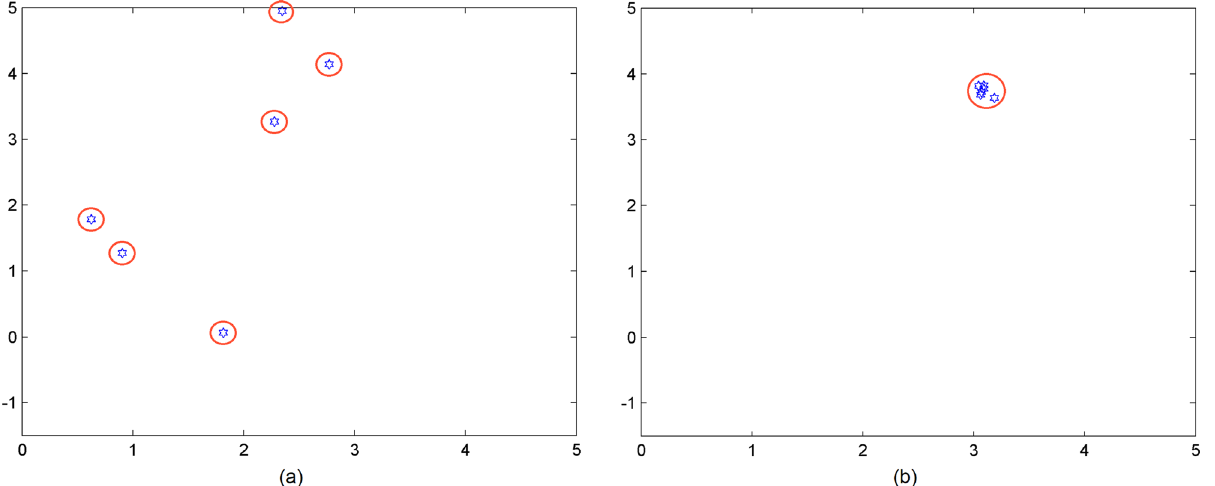
Fig. 8 The bacterial swarm during optimization a the initial bacterial position, b the final bacterial position on